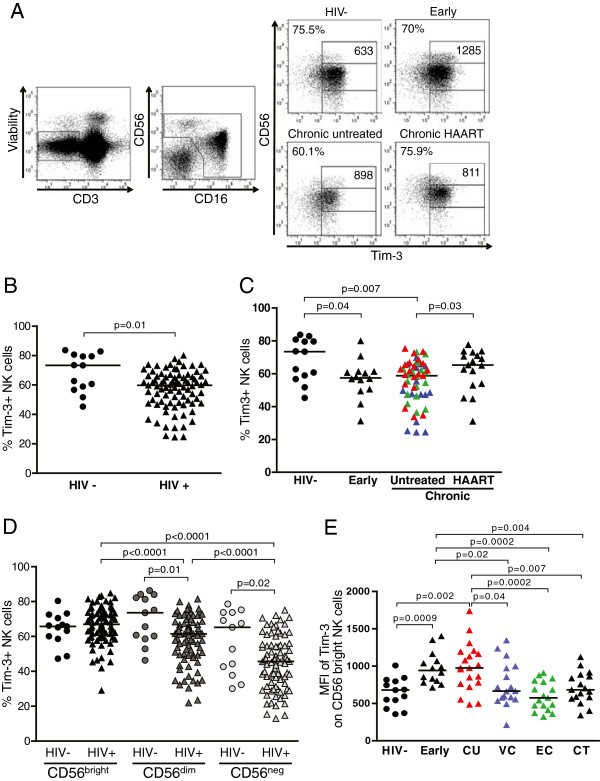
Tim-3 expression is dysregulated in HIV-1 infection. (A) Flow cytometry gating strategy: Gates are set to include CD3- lymphocytes and exclude dead cells (viability marker+). NK cell subsets are defined by the expression of CD56 and CD16, and Tim-3+ NK cells by using appropriate fluorescence-minus-one controls. The four right flow cytometry panels show representative examples of Tim-3+ bulk and CD56bright, CD56dim and CD56neg NK cells in an HIV-1 negative subject (HIV-), an individual with late primary untreated infection, an untreated chronic HIV-1 progressor, and a HAART-treated HIV-1+ patient. Percentages of Tim-3+ bulk NK cells, and MFI of Tim-3 on CD56bright NK cells are indicated on the top left of the main panel and on the top right of the CD56bright NK cell gate, respectively. (B) Dot plots represent the percentage of Tim-3+ NK cells from 13 healthy individuals and 85 HIV-1-infected subjects (C), including 14 with early untreated HIV-1 infection, 54 with chronic untreated HIV-1 infection (blue, 17 viremic controllers; green, 17 elite controllers; red, 20 untreated progressors), and 17 with HAART-treated HIV-1 infection. (D) Percentages of Tim-3 + NK cells in CD56bright (CD3-CD56+CD16-), CD56dim (CD3-CD56+CD16+) and CD56neg (CD3-CD56-CD16+) NK cells in 13 HIV-1 negative and 85 HIV-1-infected subjects. (E) MFI of Tim-3 on CD56bright NK cells in 13 healthy individuals and 14 subjects with early infection, 54 with chronic untreated HIV-1 infection, including 17 viremic controllers (blue, VC), 17 elite controllers (green, EC), 20 untreated progressors (red, CU), and 17 with HAART-treated HIV-1 infection (CT). Horizontal lines indicate the median percentages. Statistical differences with p < 0.05 are indicated and were determined using the Mann–Whitney t test to compare phenotype frequencies between two groups.